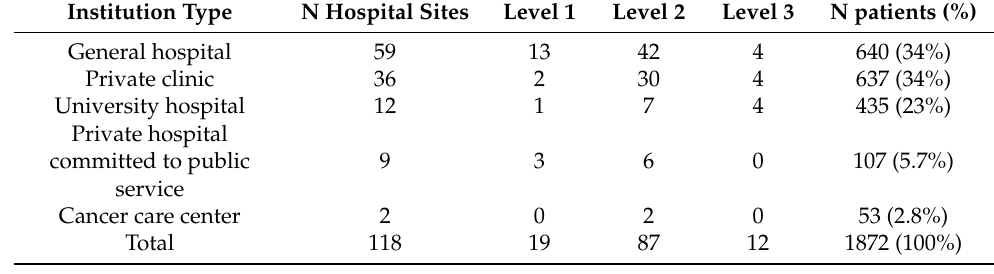
Table 1. Distribution of hospital sites by level of expertise and type of structure with number of patients initially admitted with PDAC.